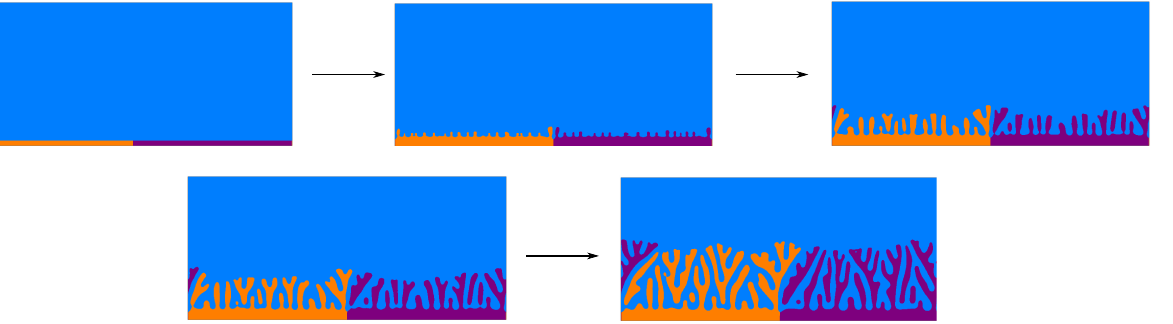
Figure 1. Temporal evolution of a tip-splitting microstructure in a supersaturated melt of composition ∆ = 0.50. The primary ridges developed at the grain boundary groove amplify into split structures along with the propagation of hillocks across the two solid grains. The combined influence of constitutionally supercooled alloy melt near the solid–liquid interface and isotropic interfacial energy promote the formation of a tip-splitting morphology. Here, the magenta and orange colors refer to the two distinct solid grains, and blue color represents the liquid phase,